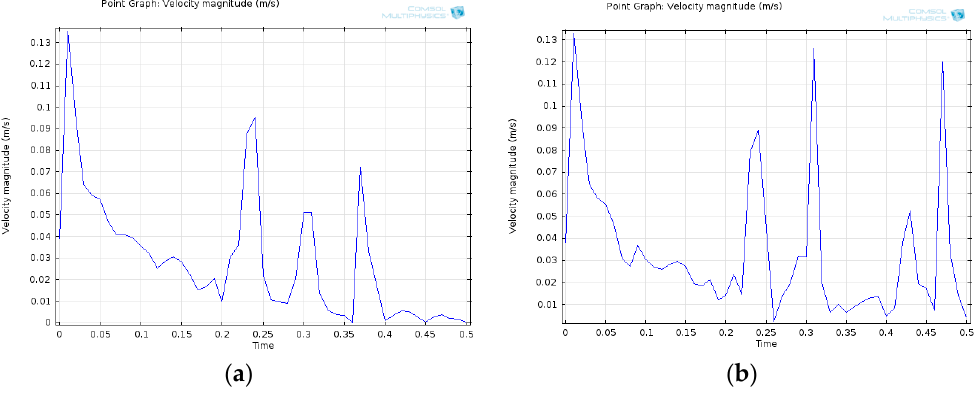
Figure 6. Time (s) vs. velocity magnitude (m/s) of the MET with a membrane thickness of 1.5 mm ( a ) and a membrane thickness of 1.0 mm ( b ).